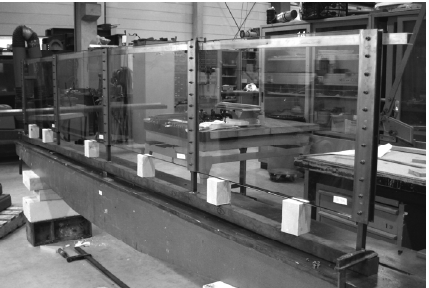
Figure 8: Test rig and load introduction; the specimen is positioned